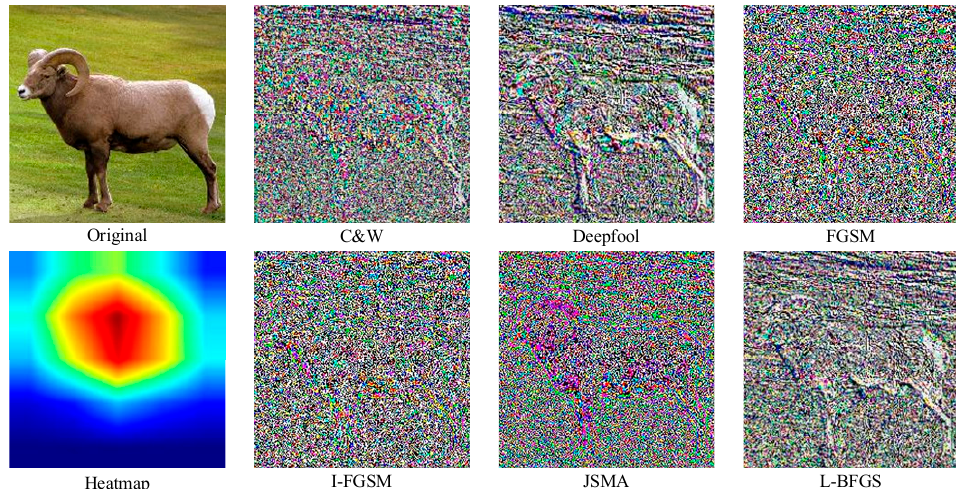
Figure 2. Visualization showing average location in the image where perturbation is added by an attacker.